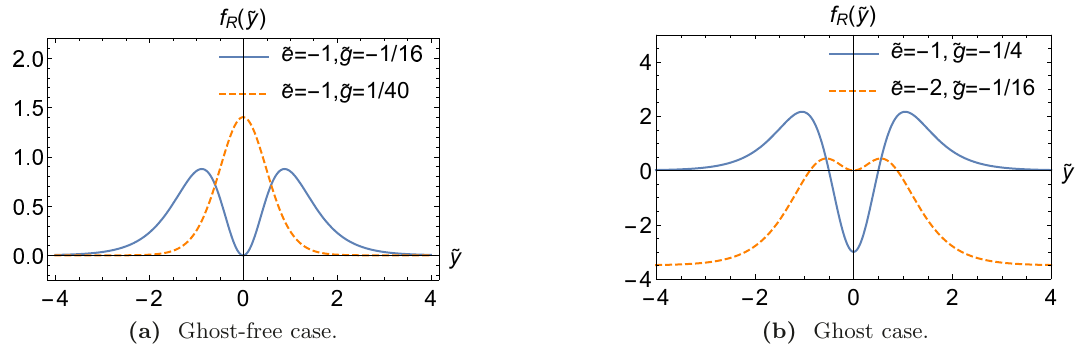
Figure 3. Plots of f R (˜ y ) in eq. (5.3) with n = 1. (a) The color lines are responsible for the critical lines where f R is always positive even at ˜ y = 0. These two lines exhibit two ghost-free cases as f R (˜ y ) > 0. (b) The two color lines illustrate that ghosts are typically contained for f R (˜ y ) < 0 in some domains of ˜ y